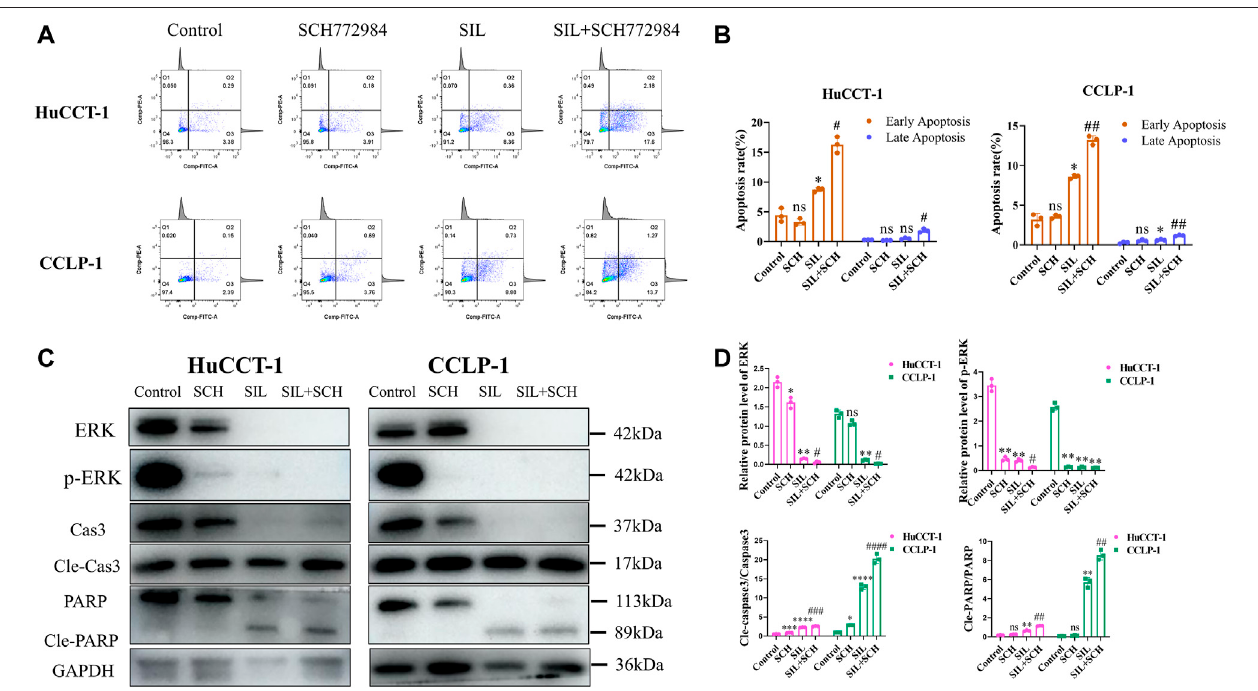
FIGURE 6 | The combined application of SCH772984 signi fi cantly aggravated apoptosis of cholangiocarcinoma cells. (A,B) . Apoptosis detection by FCM and quantitative analysis of the apoptosis rate. (C,D) . The expression of apoptosis-related proteins was identi fi ed in HuCCT-1 and CCLP-1 cell lines, and quanti fi cation results were shown by histograms. Data is shown as mean ± SD, * p < 0.05 , ** p < 0.01 , *** p < 0.001 , **** p < 0.0001 , signi fi cantly difference compared to the control group. # p < 0.05 , ## p < 0.01 , ### p < 0.001, signi fi cantly difference compared to the SIL